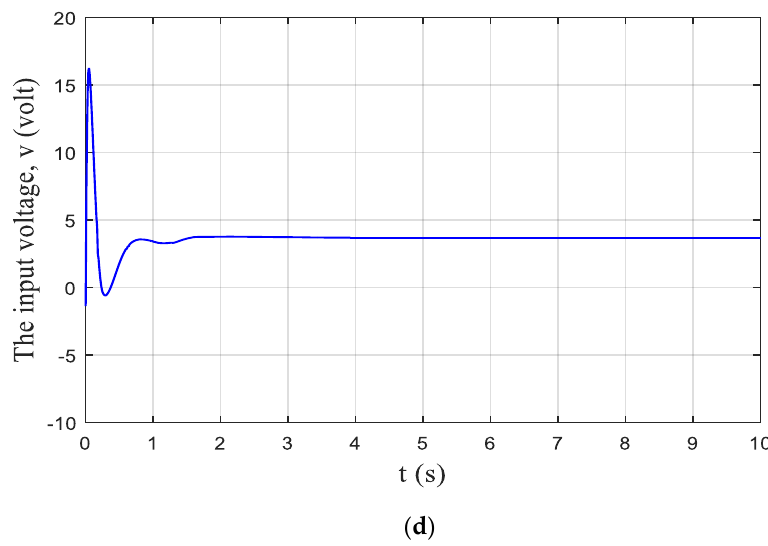
Figure 2. Results of the numerical simulations of the PMDC motor by enhanced active disturbance rejection control (EADRC)-nonlinear extended state observer (NLESO).